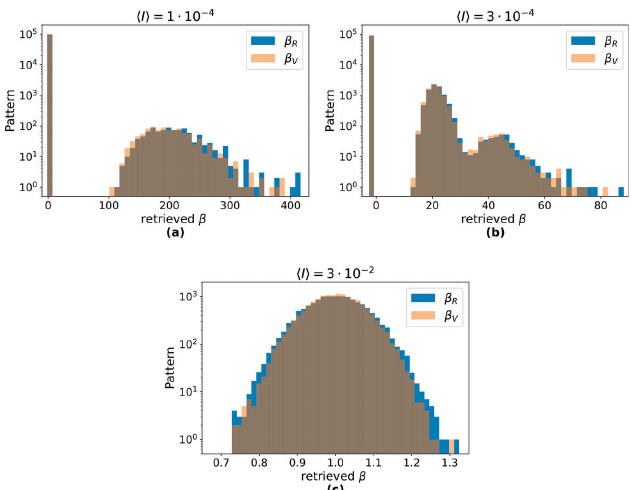
Figure 3 Histograms of speckle contrast estimates (cid:6) 1,2 and (cid:6) V , obtained from simulated patterns each consisting of one million random numbers following a Bose–Einstein distribution ( (cid:6) 0 = 1) and with means of ( a ) h I i = 10 (cid:2) 4 , ( b ) h I i = 3 (cid:4) 10 (cid:2) 4 and ( c ) h I i = 3 (cid:4) 10 (cid:2) 2 . For ( a ) and ( b ) most of the estimates are at (cid:6) = (cid:2) 1 and a minority at very high